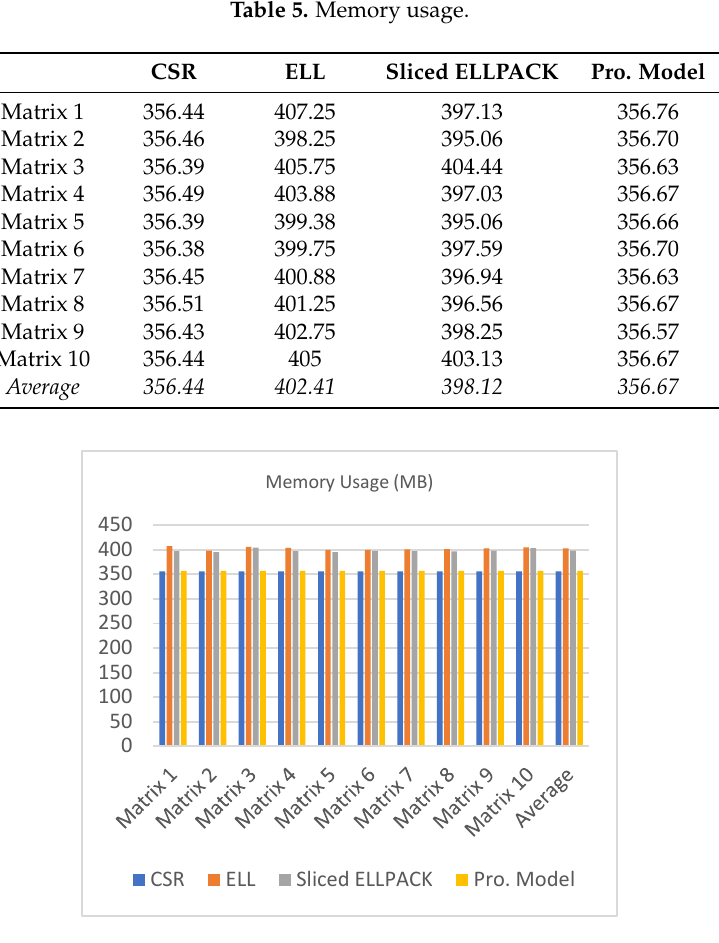
Figure 5. Memory usage.